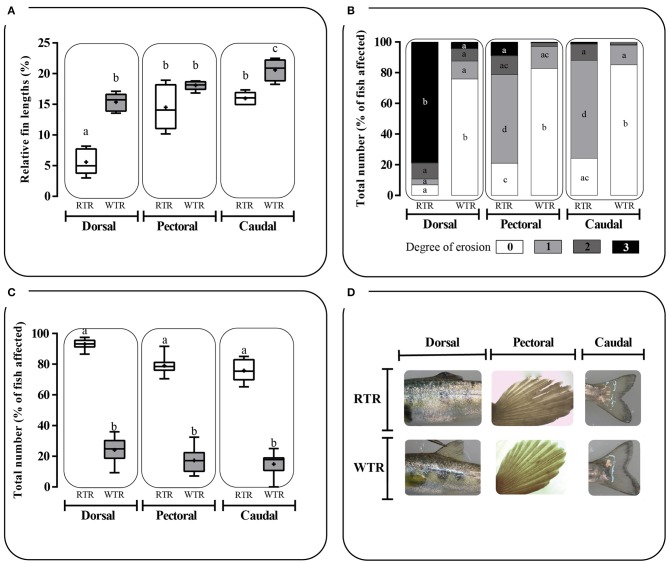
Effect of thermal range in Salmo salar fin damage expressed as: (A) Relative Fin Index, (B) degree of fin erosion and (C) total number of fish affected in (D) dorsal, pectoral and caudal fin. Fin erosion was measured utilizing an ordinal scale of 0, 1, 2, and 3, corresponding to no erosion (0% of fin eroded), mild erosion (1–24% of fin eroded), moderate (25–49% of fin eroded) and severe erosion (>50% of fin eroded), respectively. Values are represented as the mean ± SD. The experimental groups are: restricted thermal range (RTR, ΔT 1.4°C; black) and wide thermal range (WTR, ΔT 6.8°C; gray). Different letters denote significant differences between groups (2 way ANOVA; p < 0.05).